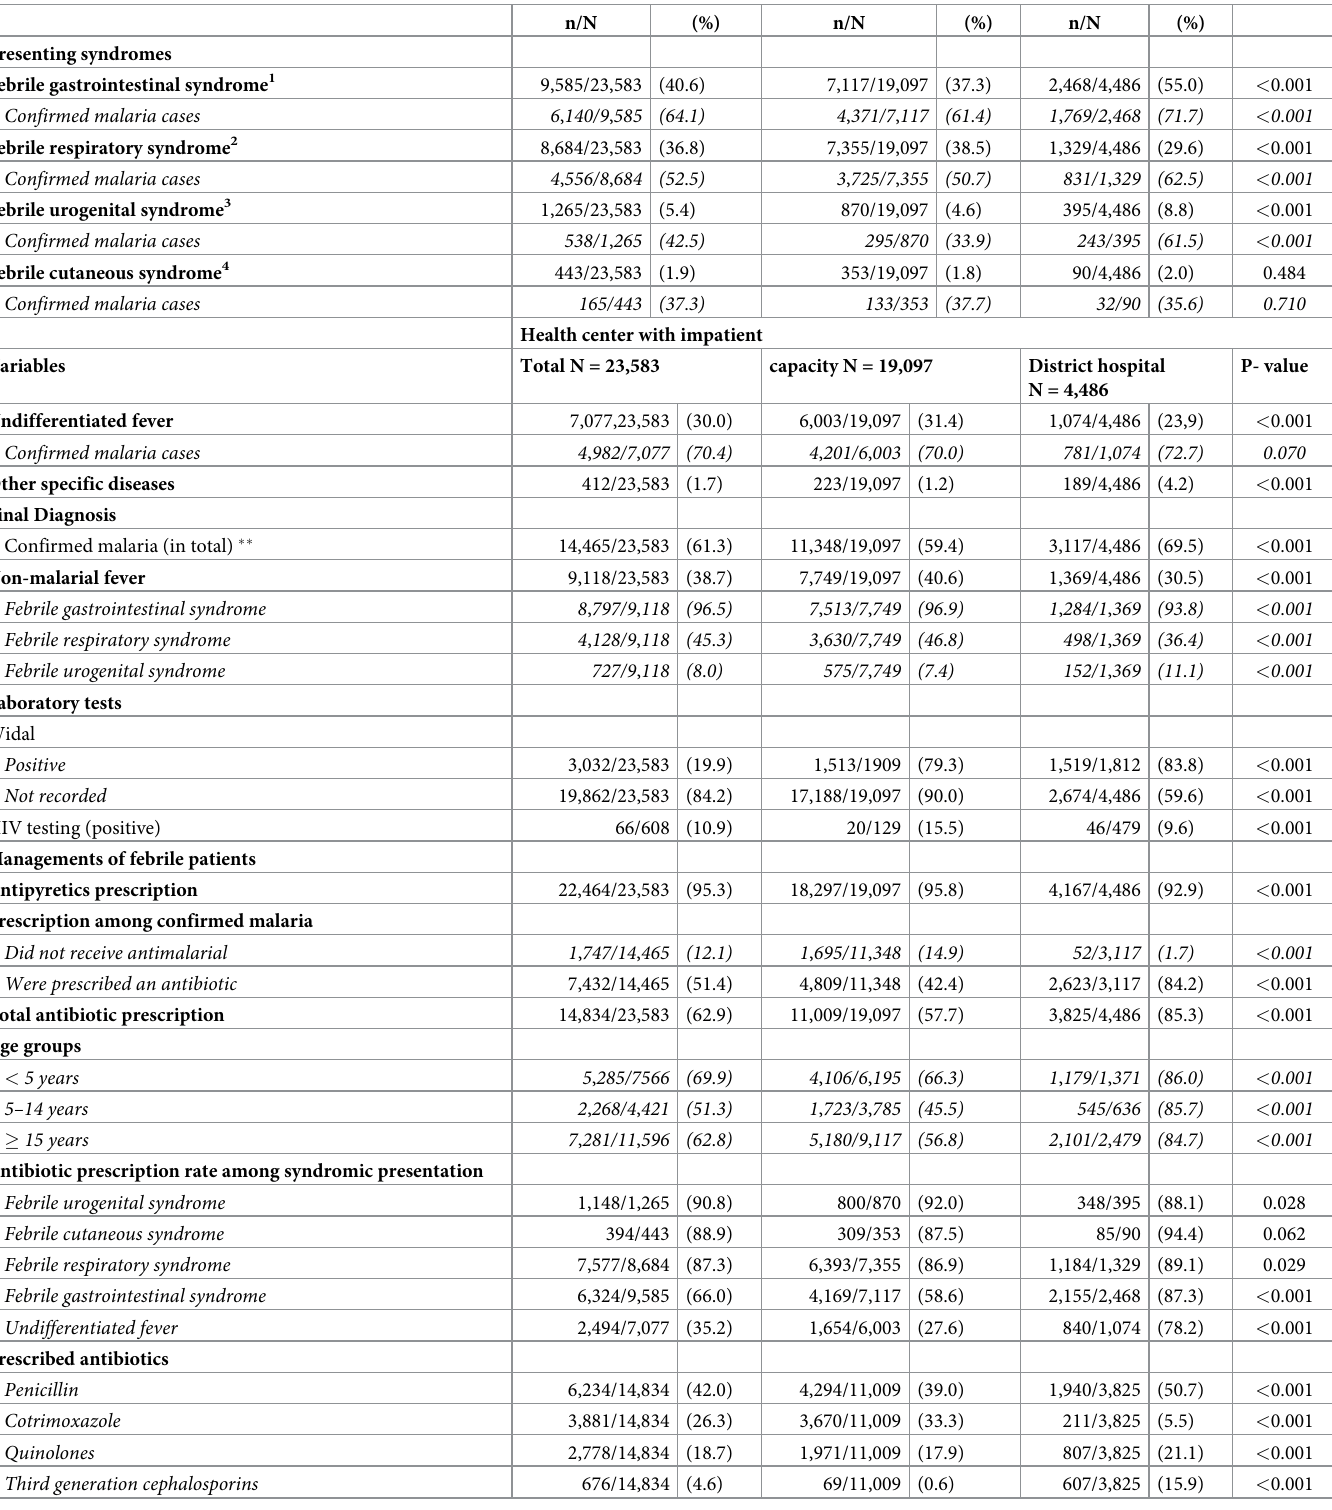
Table 2. Syndromic presentation, management and outcomes of febrile patients (N = 23,583) by facility type in the rural health district of Fore´cariah, Guinea,